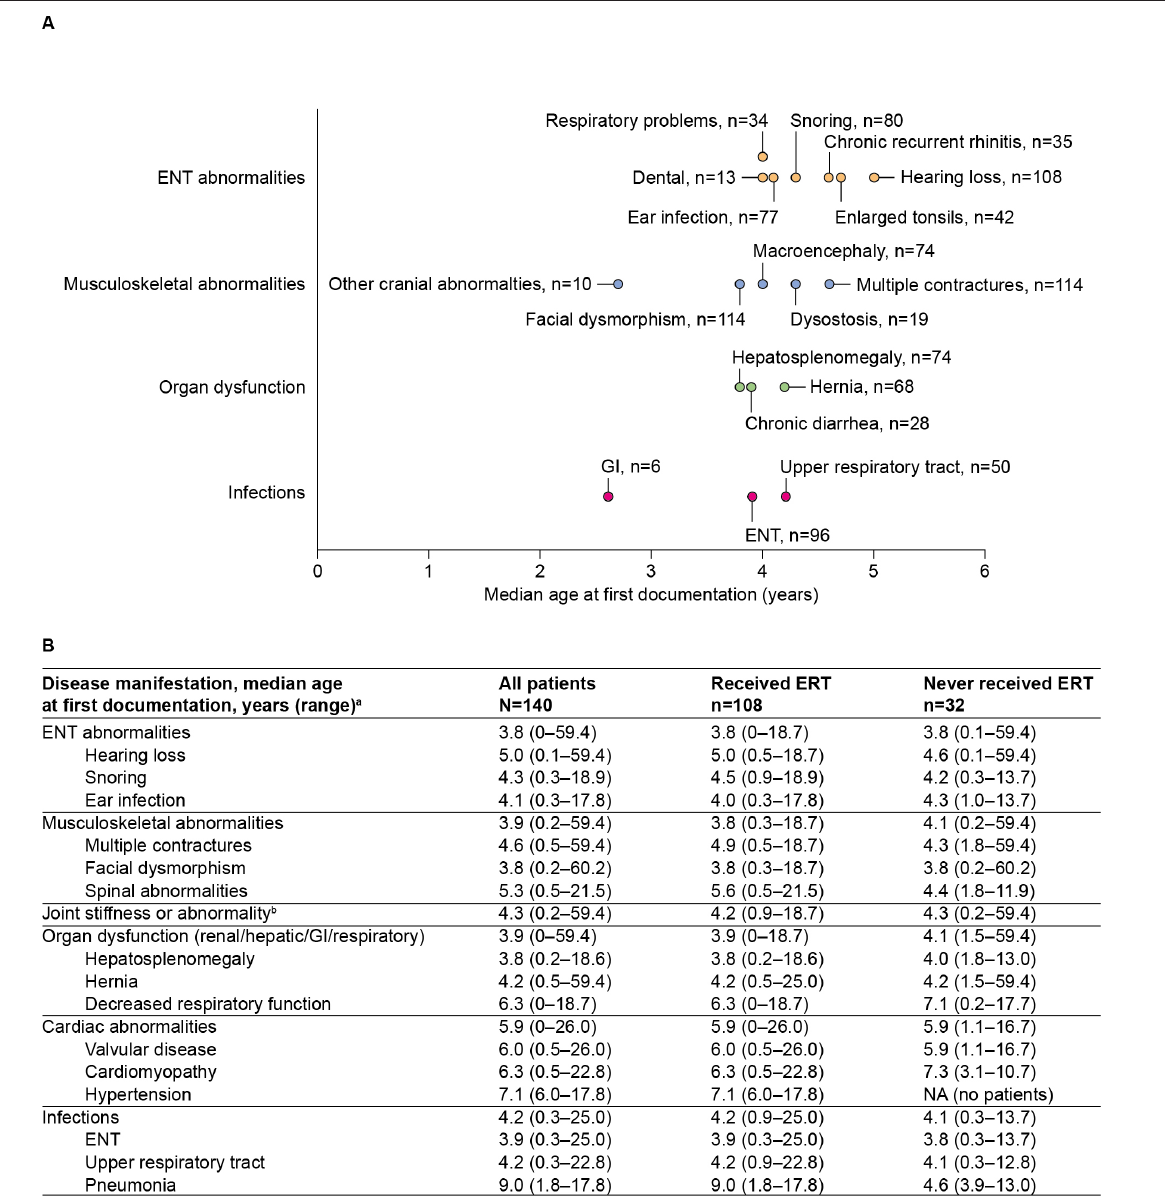
Figure 2. Median Age at First Documentation of Clinical